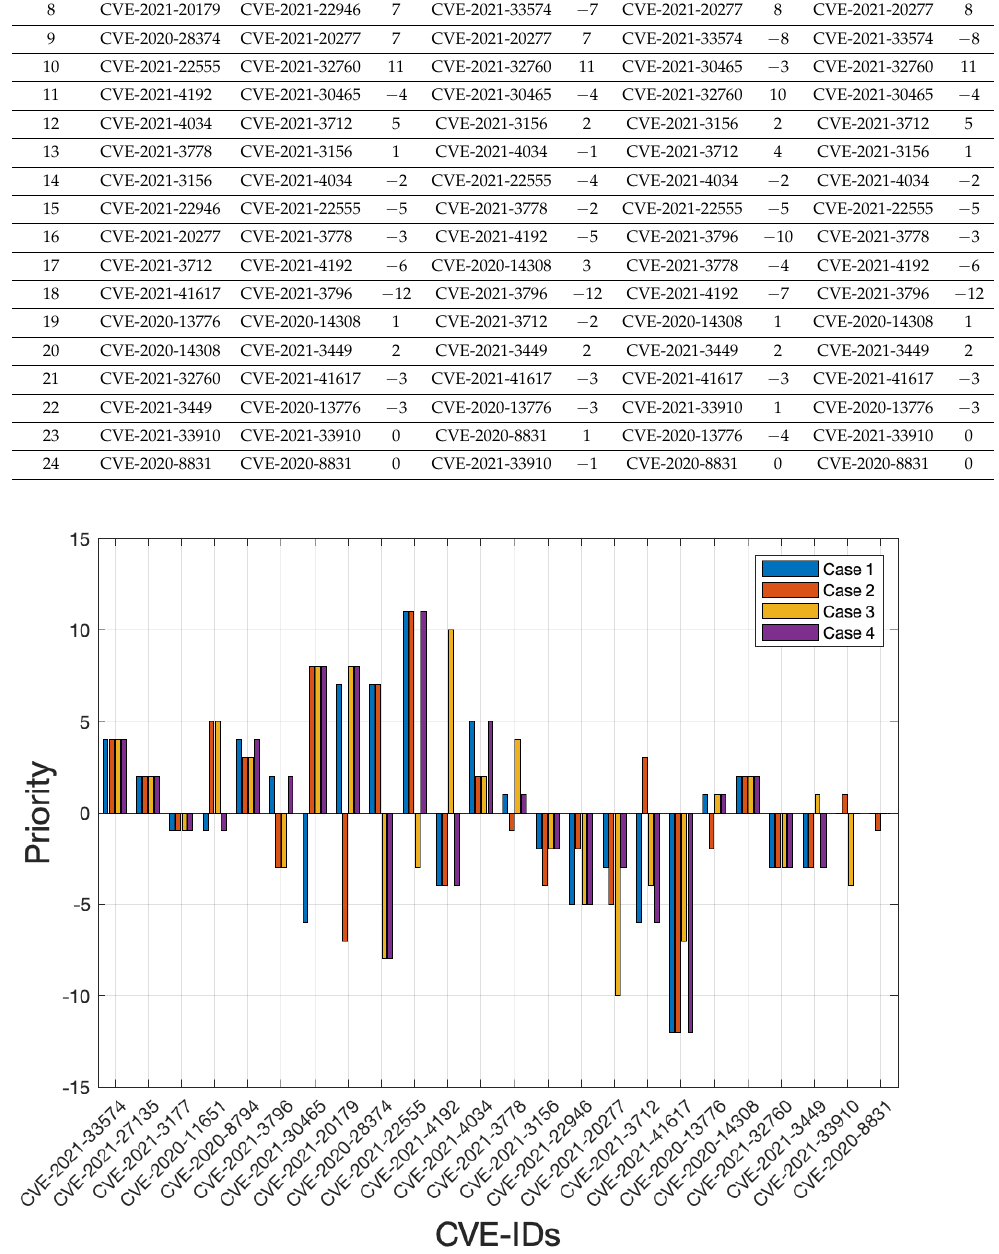
Figure 7. The ∆ value of patch-priority orders in Rudder CVE-plugin and Case 1-4 of ACVRM. We also noticed that Rudder listed the CVE-IDs with the same SC randomly (e.g., priority 1 to 5 have a SC = 9.8, and the position is not related to the age of the CVE-IDs). However, ACVRM considered the age of the CVE-IDs in prioritization when the PS value